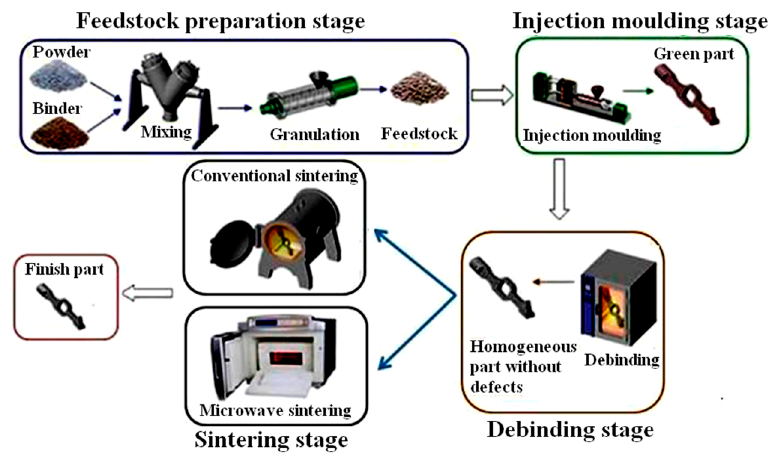
Figure 1. The sequential stages of PIM (powder injection molding) process to get the final products [2].